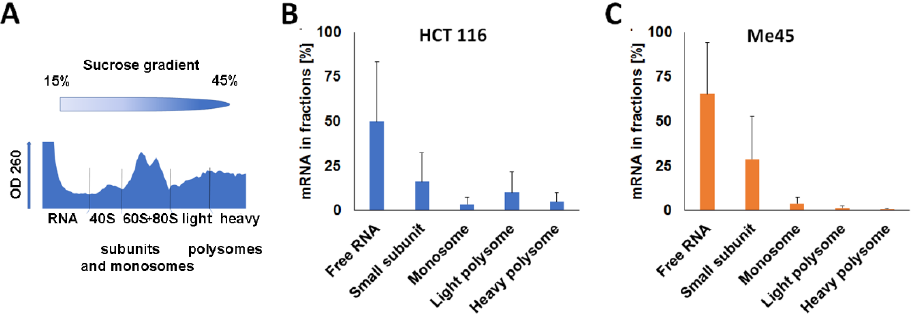
Figure 3. Distribution of mRNA for Renilla luciferase in fractions from sucrose gradients of cell extracts. ( A ) optical density profile of a gradient (HCT116 cells); ( B , C ) distribution of mRNA in sucrose gradient fractions of extracts from ( B ) HCT116 or ( C ) Me45 cells assessed by RT-qPCR (mean from three independent experiments, vertical lines show standard deviation).